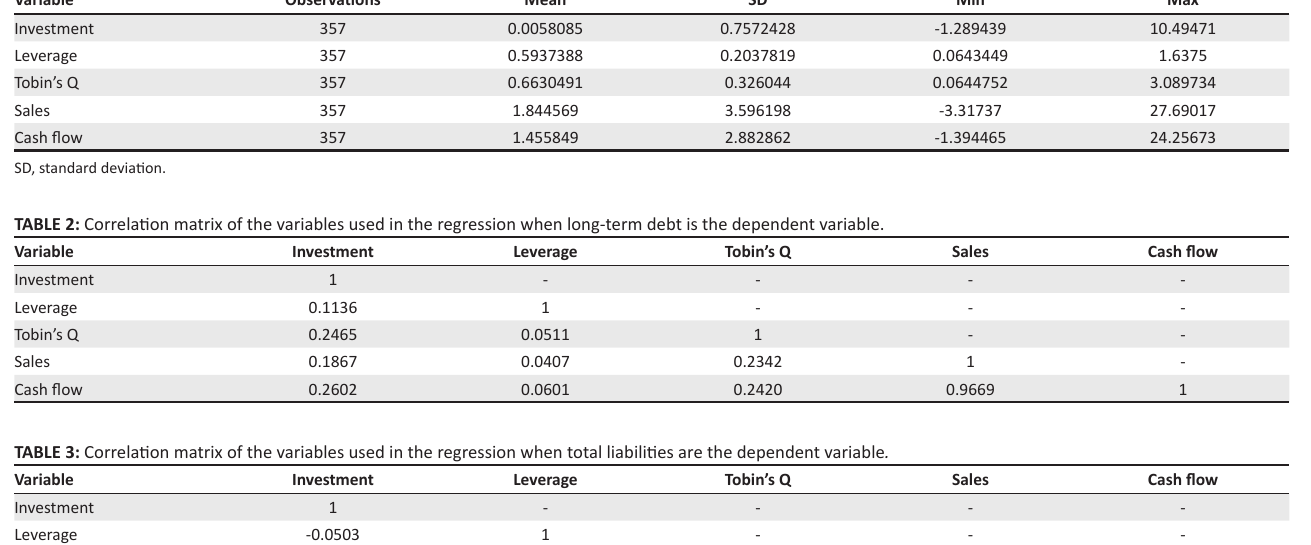
TABLE 1: Descriptive statistics of the key variables. Variable Observations